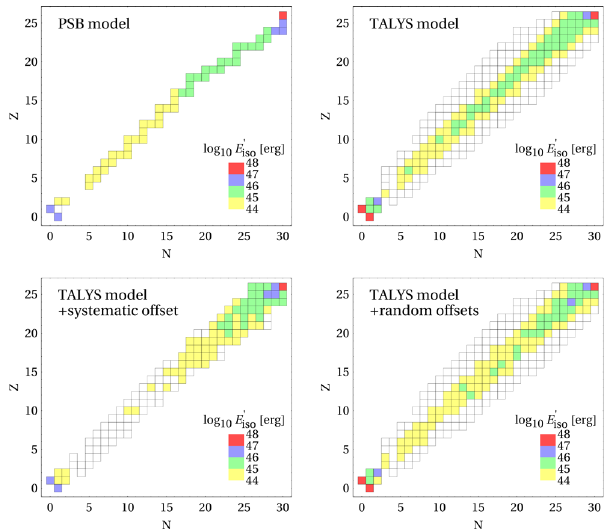
Figure 4. Disintegration chain of 56 Fe in a GRB shell with the colors representing the total energy per isotope in the SRF (see legend). White boxes correspond to energies lower than 10 44 erg s − 1 . The upper row shows the PSB model (left) and TALYS (right, CRPropa2 for the lighter elements), while the lower row shows the TALYS setup including di ff erent systematic assump- tions (see main text). The GRB parameters are L γ, iso = 10 52 erg s − 1 , Γ = 300, t v = 0 . 01 s, z = 2 and an E − 2 injection spectrum. Figure taken from [12].